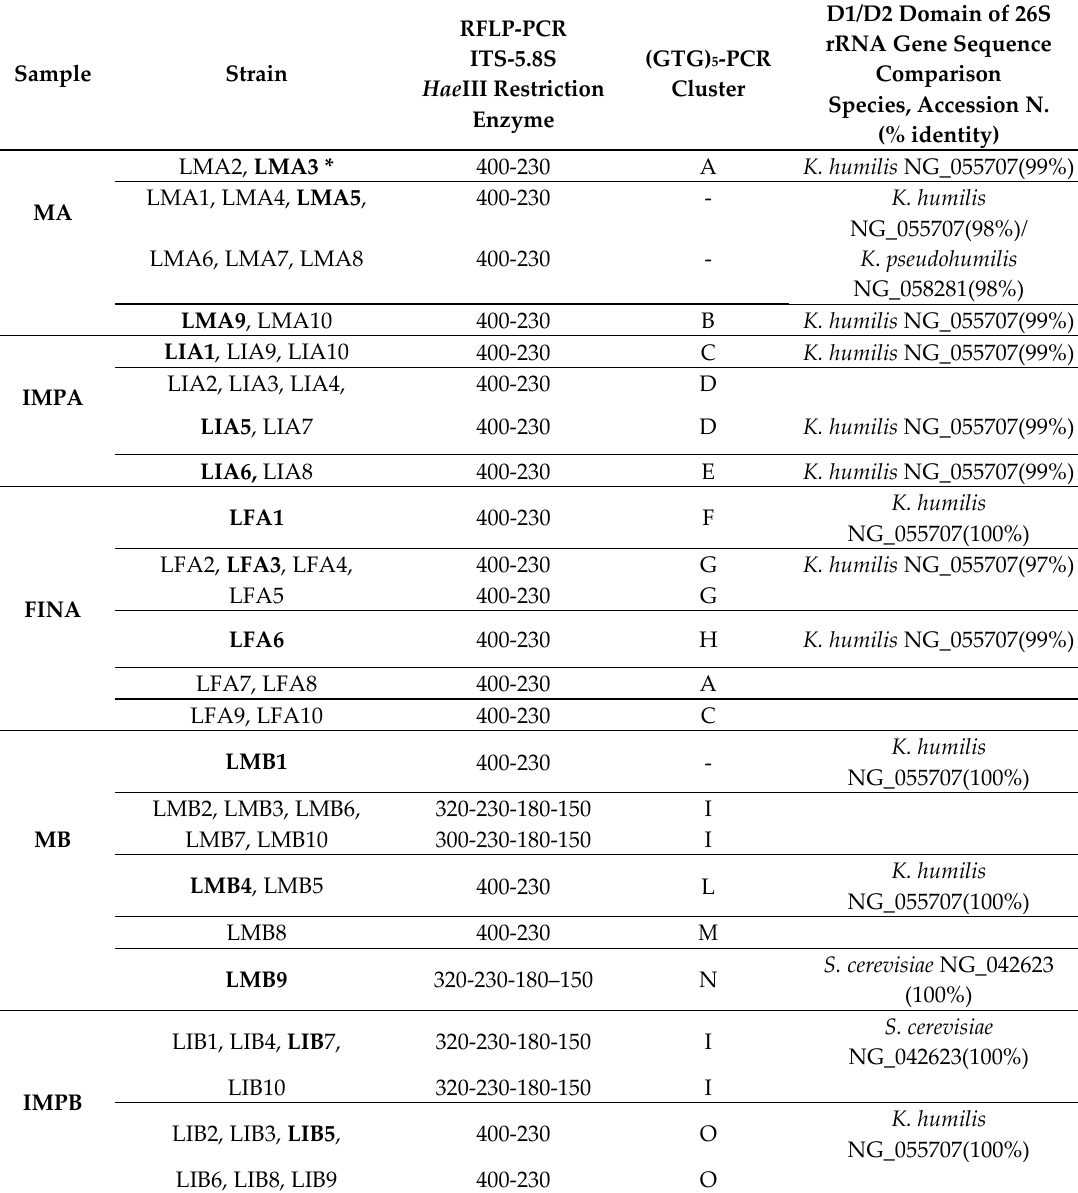
Table 1. RFLP analysis, (GTG) 5 -PCR and sequencing of D1/D2 domain of the 26S rDNA gene of the yeast strains isolated from sourdough’s